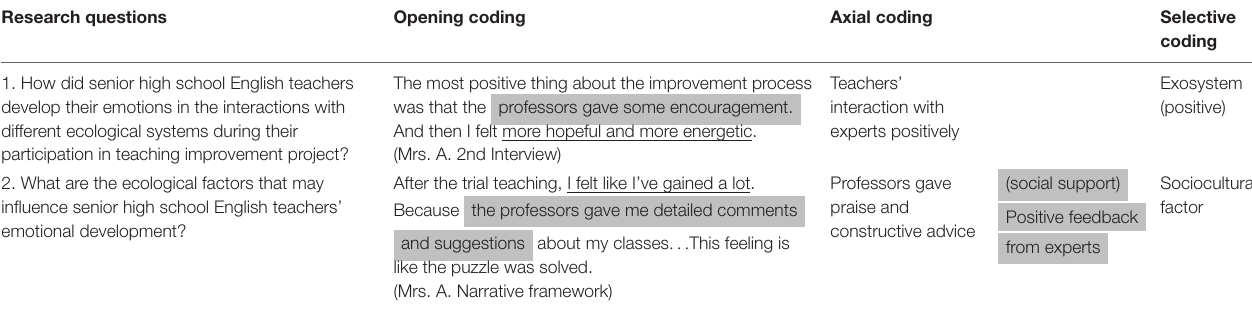
TABLE 2 | A sample of data coding